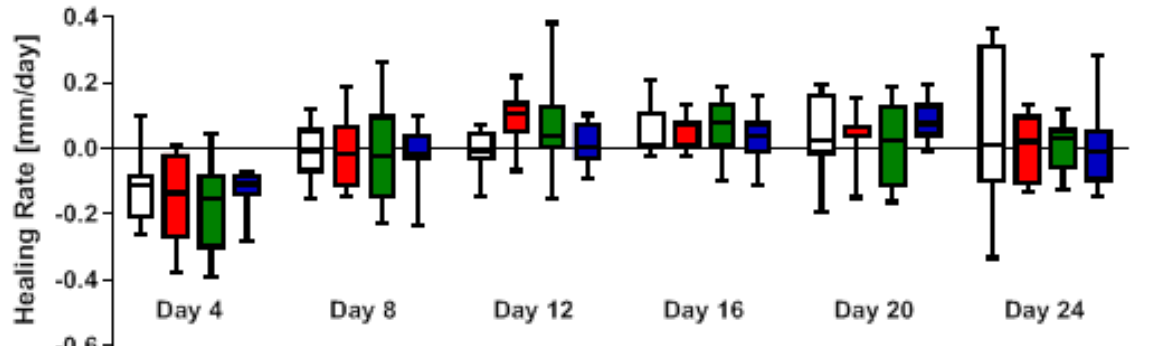
Figure 4. Effects of Repuls pulsing LED light therapy on the wound healing rate in a diabetic wound healing model in mice over a center-weighted 4-day range. Wounds were excised and treated with different wavelengths for 6 min every other day for 28 days. The healing rate was calculated using data from the wound surface. The color of the bars shows the color of PBM wavelength; from right to left control, red, green and blue light, respectively. n = 8.